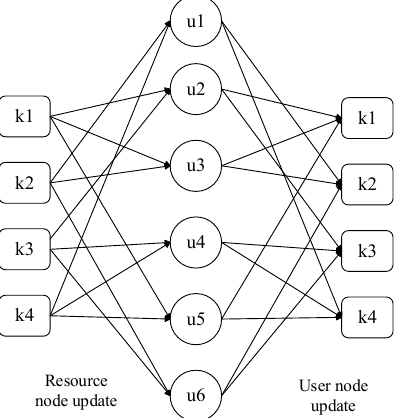
Figure 4. The Update process of MPA algorithm